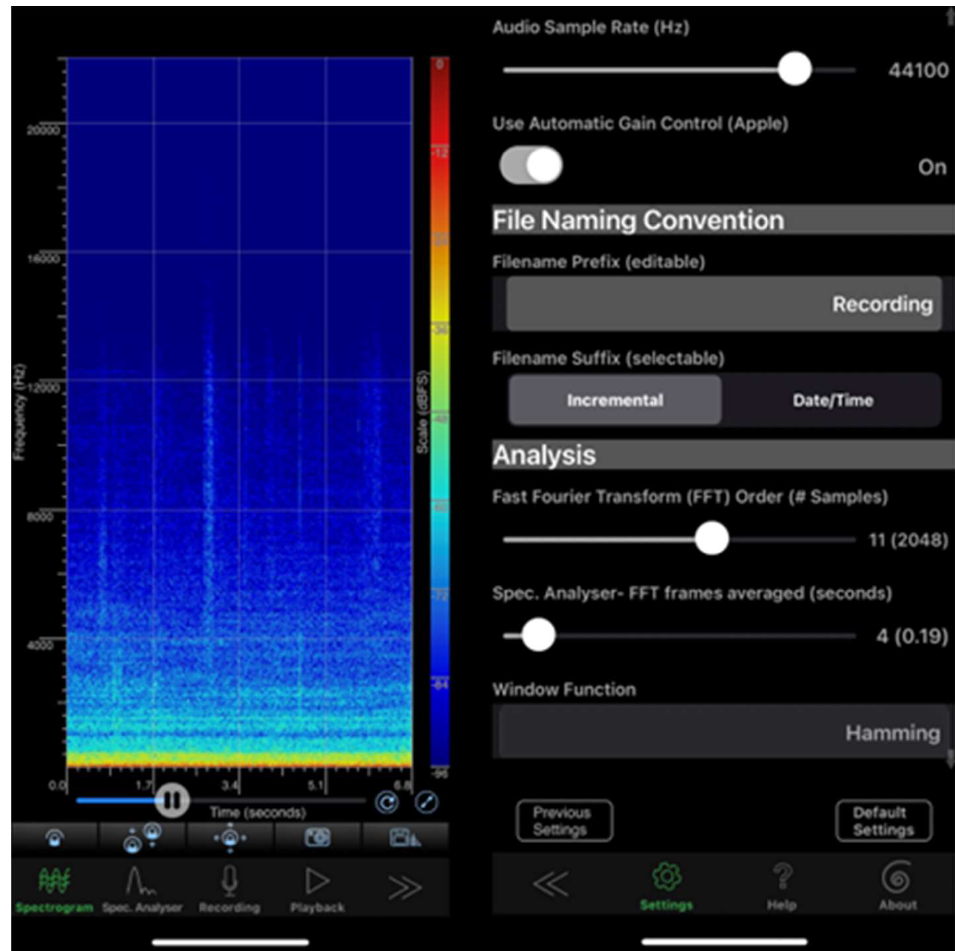
Figure 9. Hamming window function by the measurement industrial fault signals.